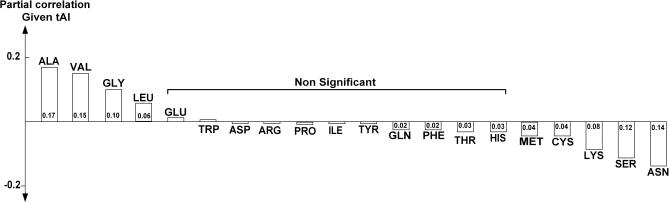
Partial Correlations between the Frequencies of Amino Acids Composing a Protein and Its Abundance Level (after Controlling for the Effect of tAI)